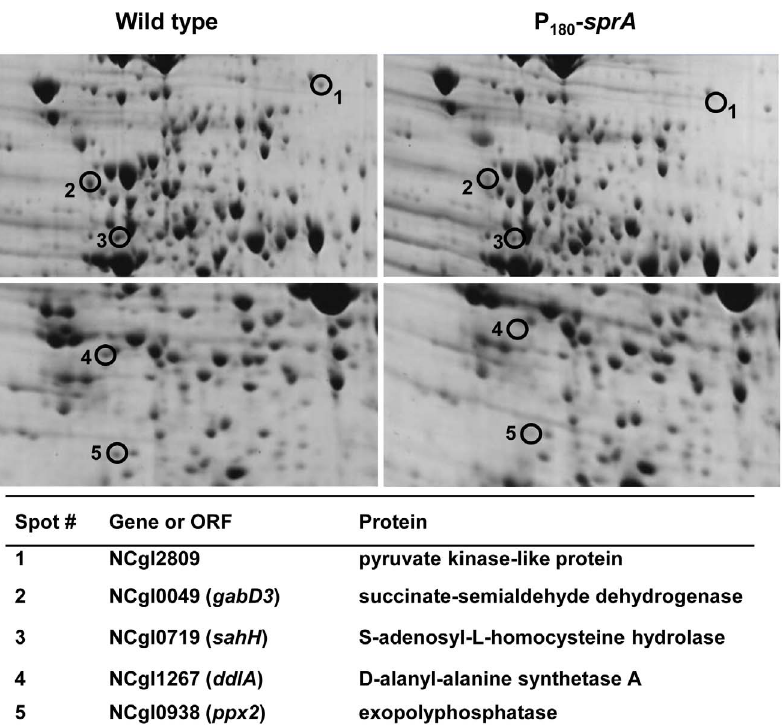
Figure 8. Identification of protein affected in sprA -overexpressing C.glutamicum (P 180 - sprA ). 2D-PAGE was performed as described in the Materials and Methods. A total of 150 m g of protein was loaded onto each gel. The identity of each protein spot was determined by electrospray ionization mass spectroscopy.